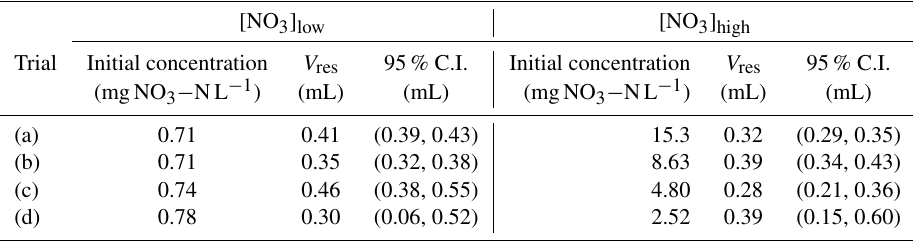
Table 2. Initial NO − concentrations, calculated effective residual volumes (Vres), and 95% confidence interval (C.I.) from source contami- 3 nation trials (a)–(d).